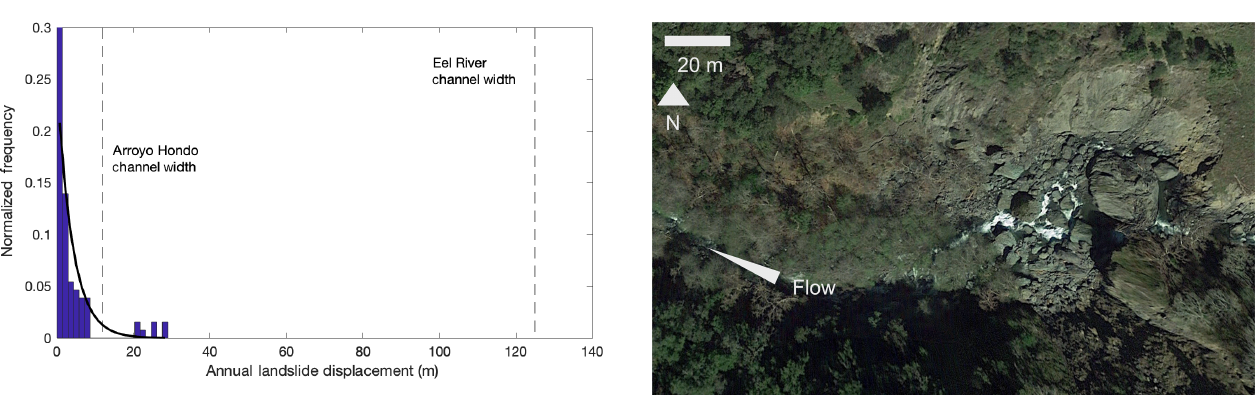
Figure 13. © Google Earth satellite image of Arroyo Hondo at the toe of the Oak Ridge earthflow during high-flow conditions, 11 March 2017. Flow is from right to left, and north is